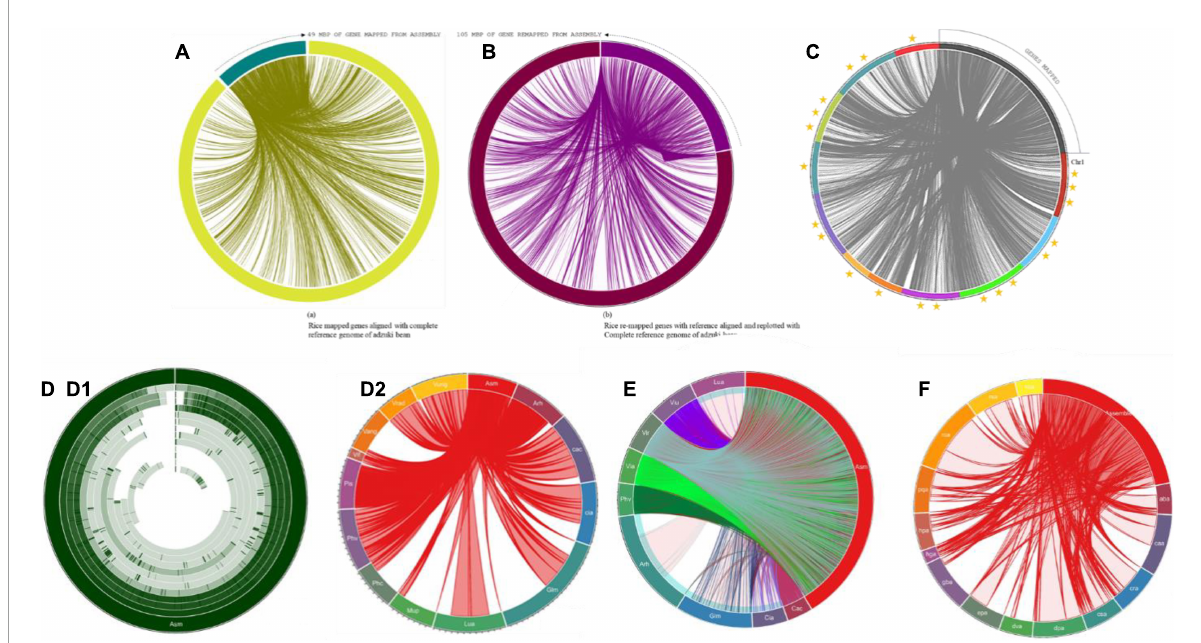
FIGURE8 (A) Mapping of predicted genes with reference genome of Vigna angularis ; gene distribution of 49 Mbp of genes with ref genome. (B) Mapping of genes predicted from remapping with reference genome of Vigna angularis ; gene distribution of 105 Mbp of genes with ref genome. (C) Mapped genes rice bean are aligned with Vigna angularis chromosomes. Three star rated chromosome shares 40 Mbp of genome size. Two star rated shares > 30 Mbp of genome size and single star rated chromosomes are 19 Mbp of genome map. (D) Circular distributions rice bean genome mapping with Arachis hypogea , Cajanus cajan , Cicer arietinum , Glycine max , Lupinus angustifolius , Mucuna pruriens , Phaseolus coccineus , Phaseolus vulgaris , Pisum sativum , and Vicia faba . (D1) circular distribution and (D2) Connective distributions of rice bean